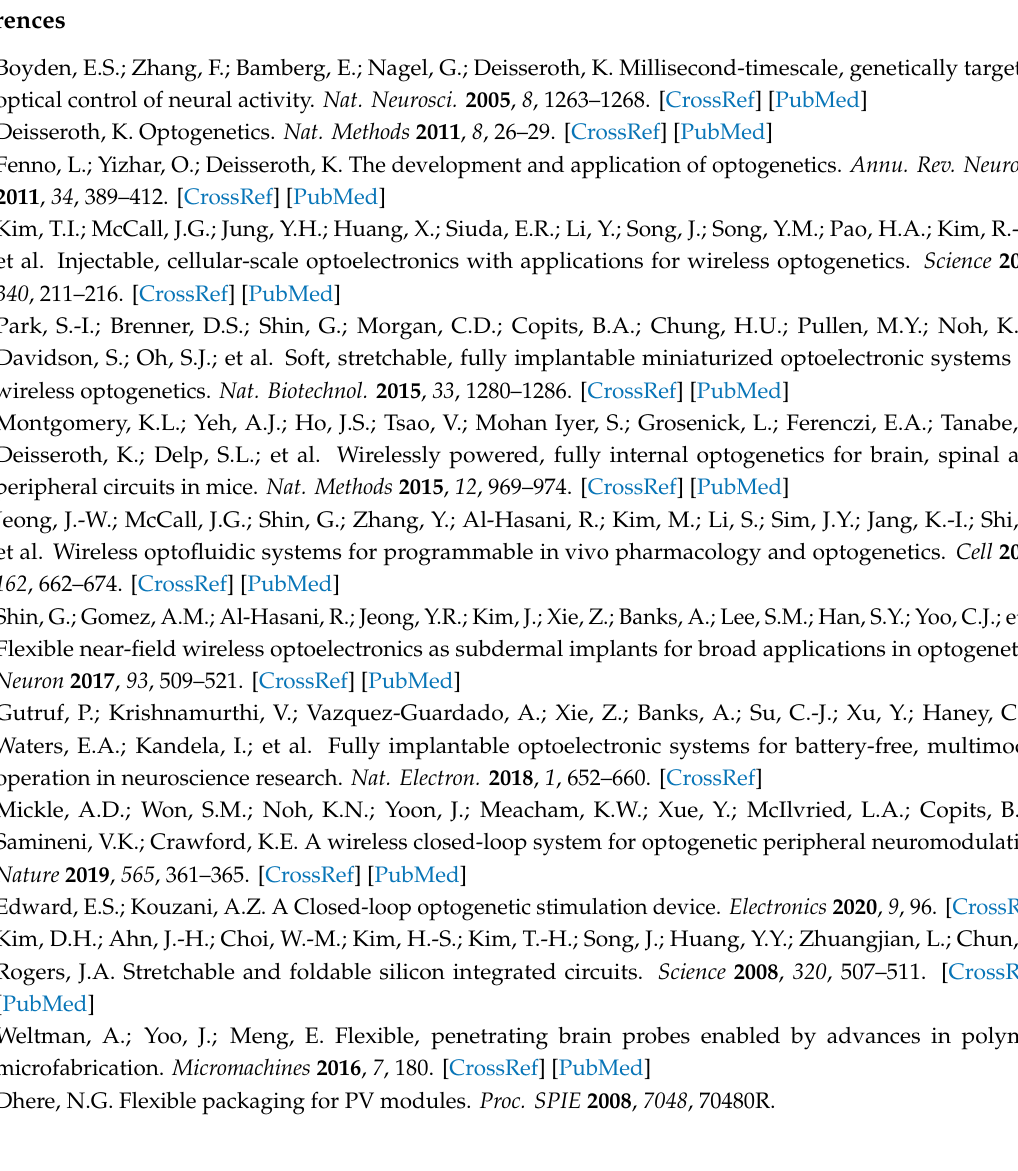
immersion time in phosphate buffer solution (PBS) (1 M, pH 7.4) with different temperatures.